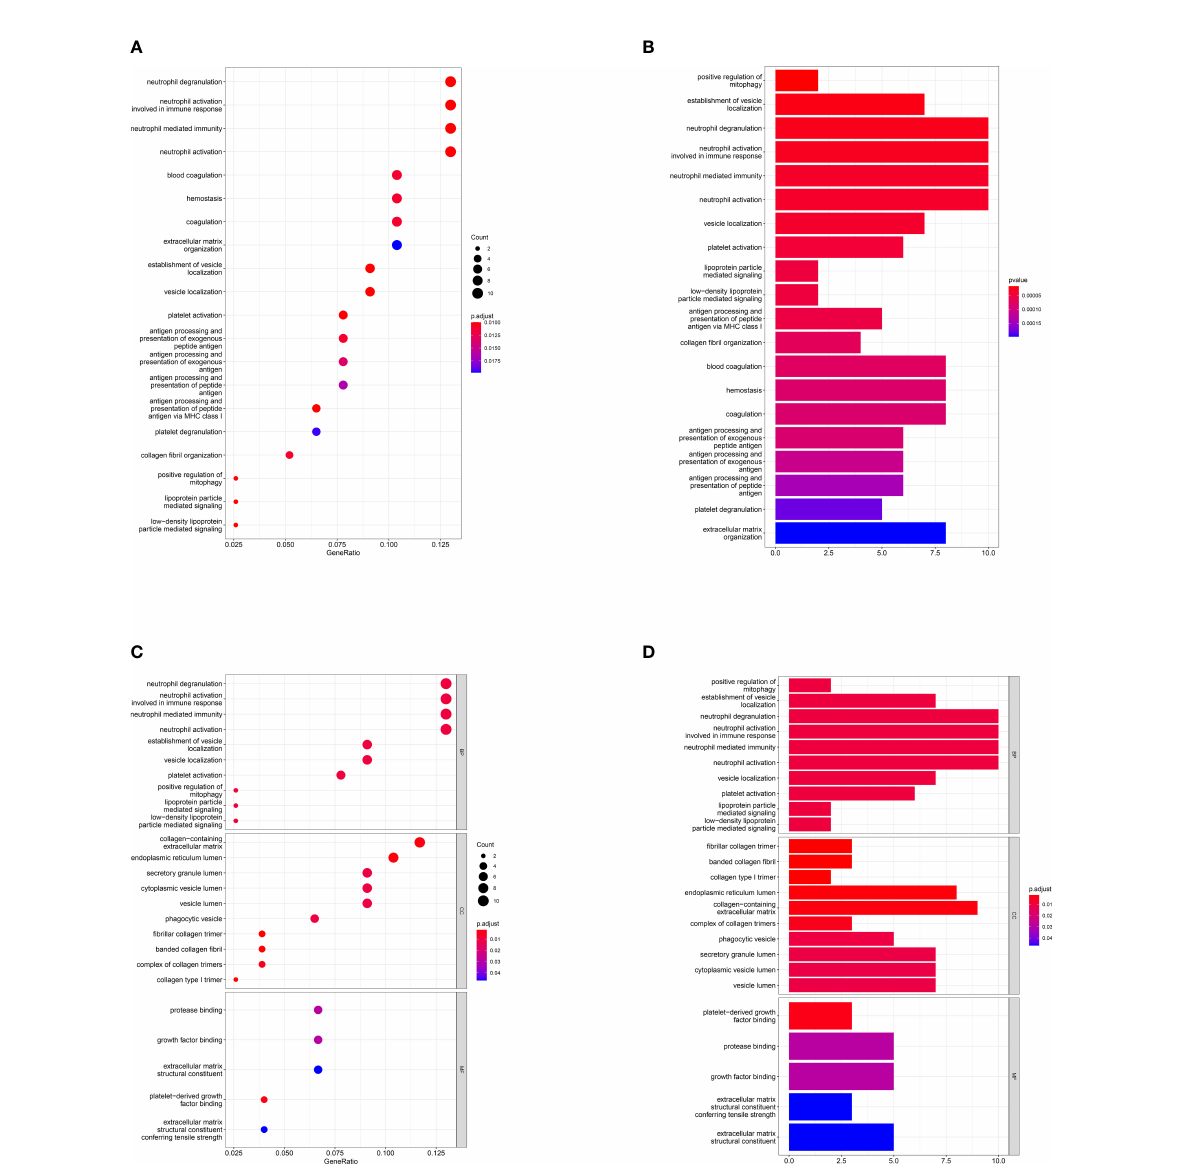
FIGURE 3 Gene Ontology pathway enrichment analysis. Result of GO pathway enrichment analysis of the 80 common DEGs, the dot plot (A) and bar plot (B) . Biological process (BP), cellular component (CC), and molecular function (MF) analysis results of 80 common DEGs, the dot plot (C) and bar plot (D) . X-axis represents the proportion of DEGs and Y-axis on behalf of the different categories. The size of the circle manifests the number of genes enriched in each category and different properties are denoted by the color of the